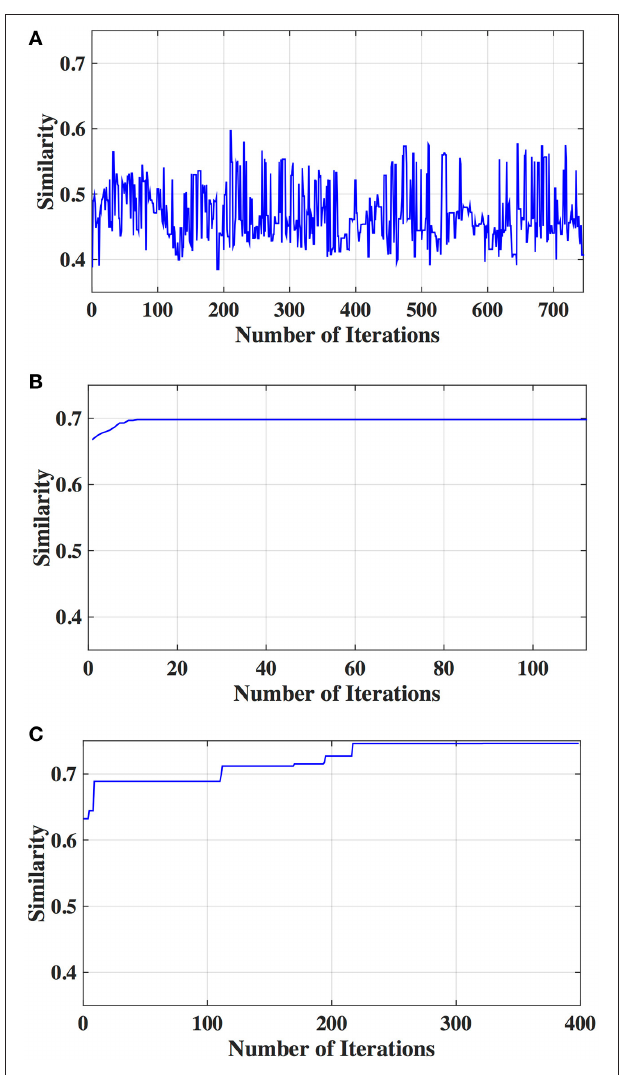
FIGURE 3 | Similarity between connectivity and phenotypic variables obtained from different iterations using hierarchical clustering and different feature selection methods: (A) SFR, (B) SFS, and (C) GA.